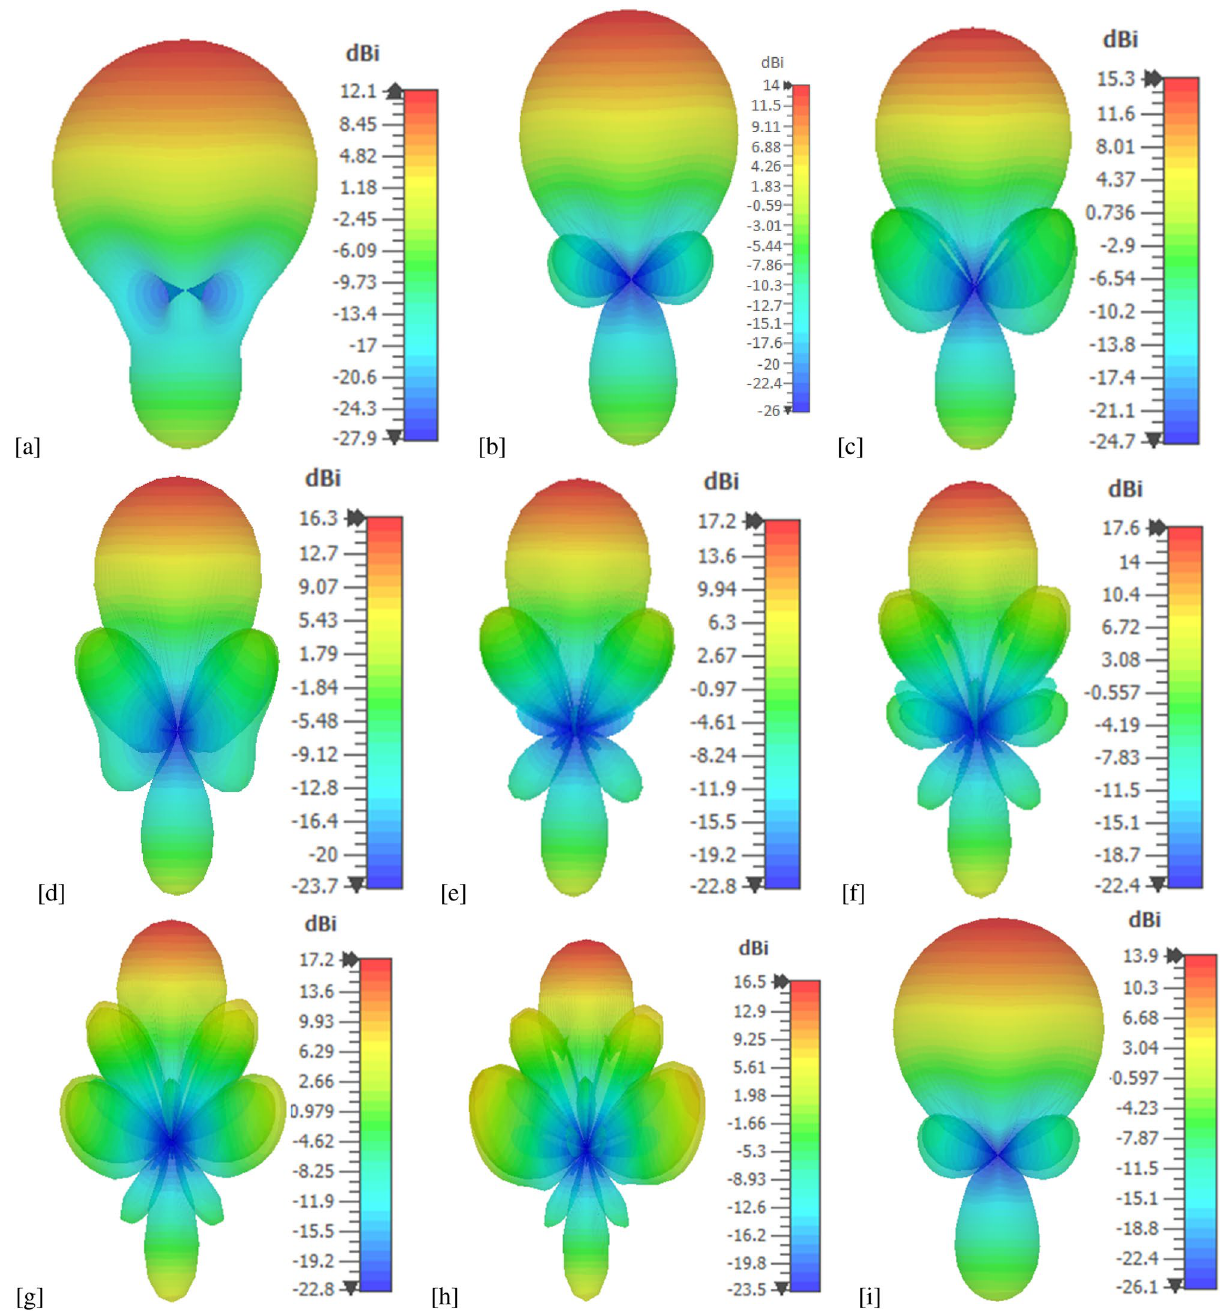
Figure 7. 3D far-field radiation pattern of the antenna at ( a ) 1 THz, ( b ) 1.25 THz, ( c ) 1.5 THz, ( d ) 1.75 THz, ( e ) 2 THz, ( f ) 2.25 THz ( g ) 2.5 THz, ( h ) 2.75 THz, and ( i ) 3 THz in mode